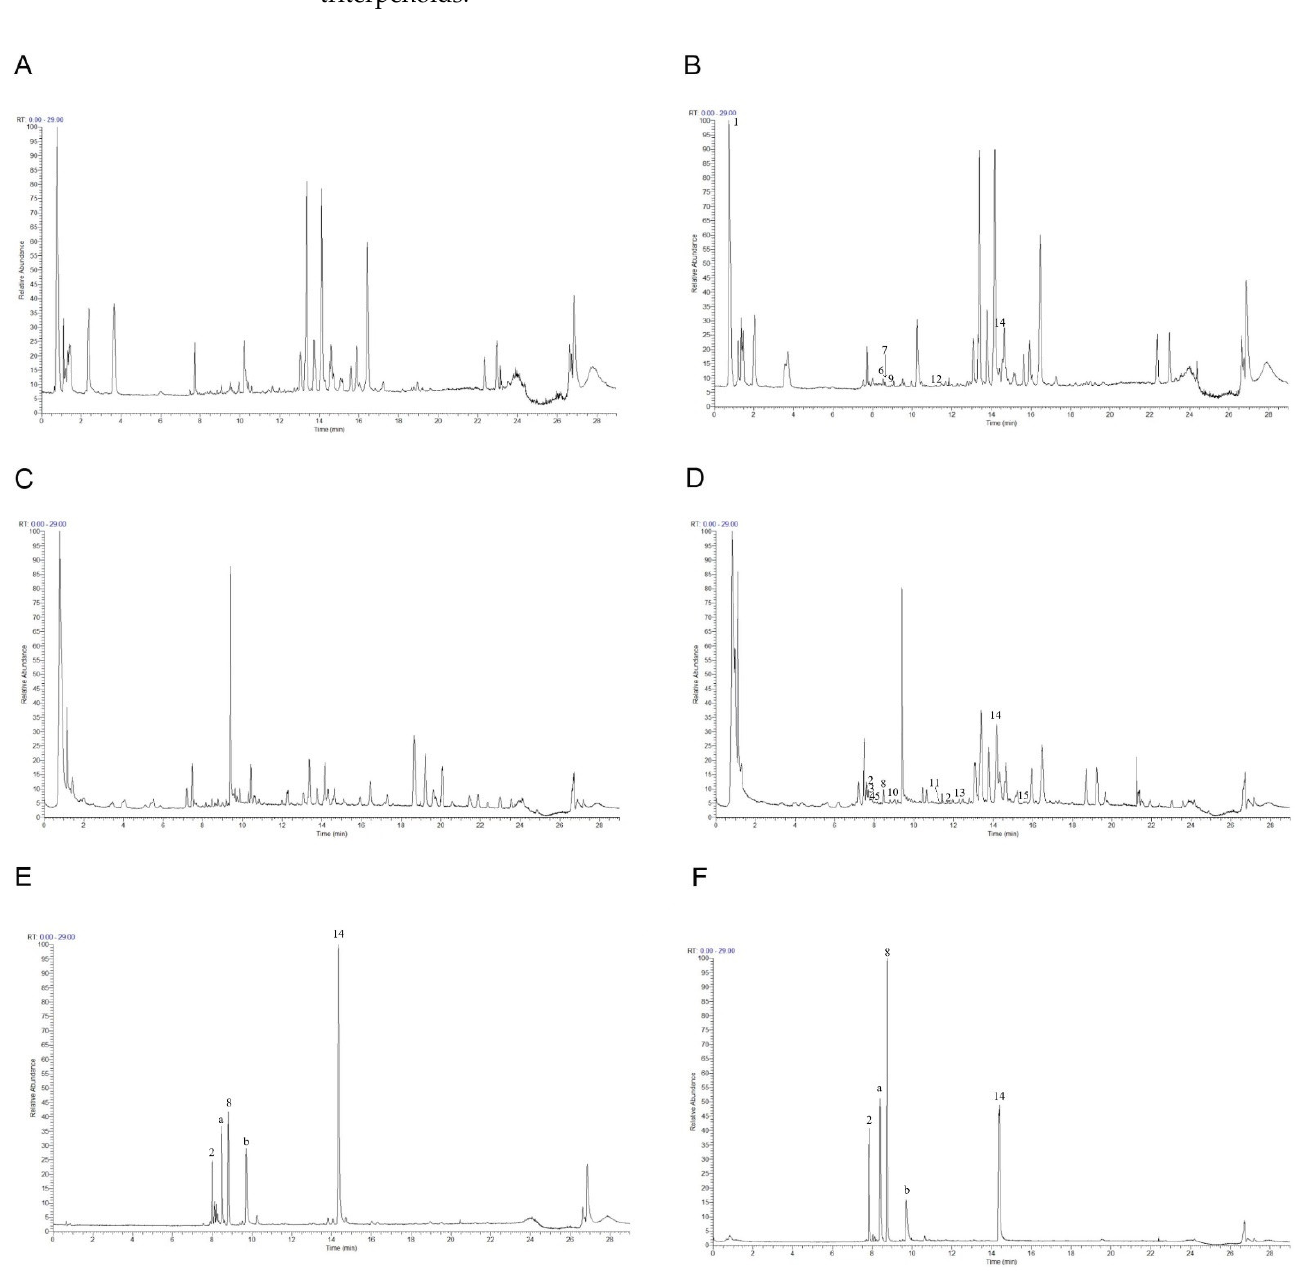
Figure 4. The total ion chromatograms: ( A ) Blank plasma in positive ion mode; ( B ) plasma containing roasted licorice in positive ion mode; ( C ) blank plasma in negative mode; ( D ) plasma containing roasted licorice in negative mode; ( E ) standard sample in positive ion mode; ( F ) standard sample in negative ion mode. 2, liquiritin apioside; 8, liquiritigenin; 14, glycyrrhetinic acid; a, isoliquiritin; b, glycyrrhizic acid.